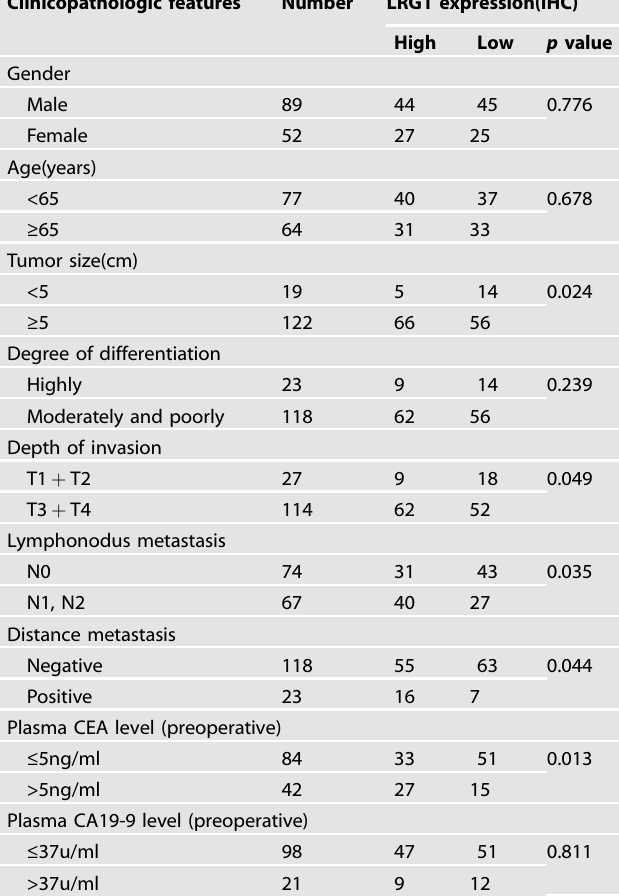
Table 1. Correlation between LRG1 expression and clinicopathological parameters of CRC.